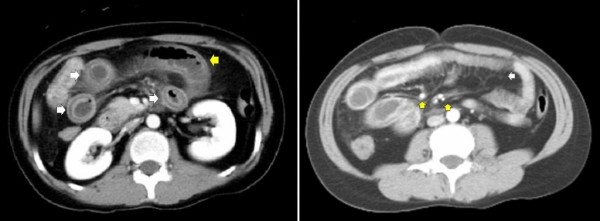
Computed tomography scans of the abdomen. (A) Left image shows distension of the bowel (yellow arrow), diffuse bowel wall thickening (maximum of 8.4 mm), abnormal bowel wall enhancement (double halo or target sign, white arrow). (B) Right image shows mesenteric edema, engorged mesenteric vessels (yellow arrow), prominence of mesenteric vessels with a palisade or comb-like arrangement (comb sign, white arrow). Pneumatosis cystoides intestinalis was absent.